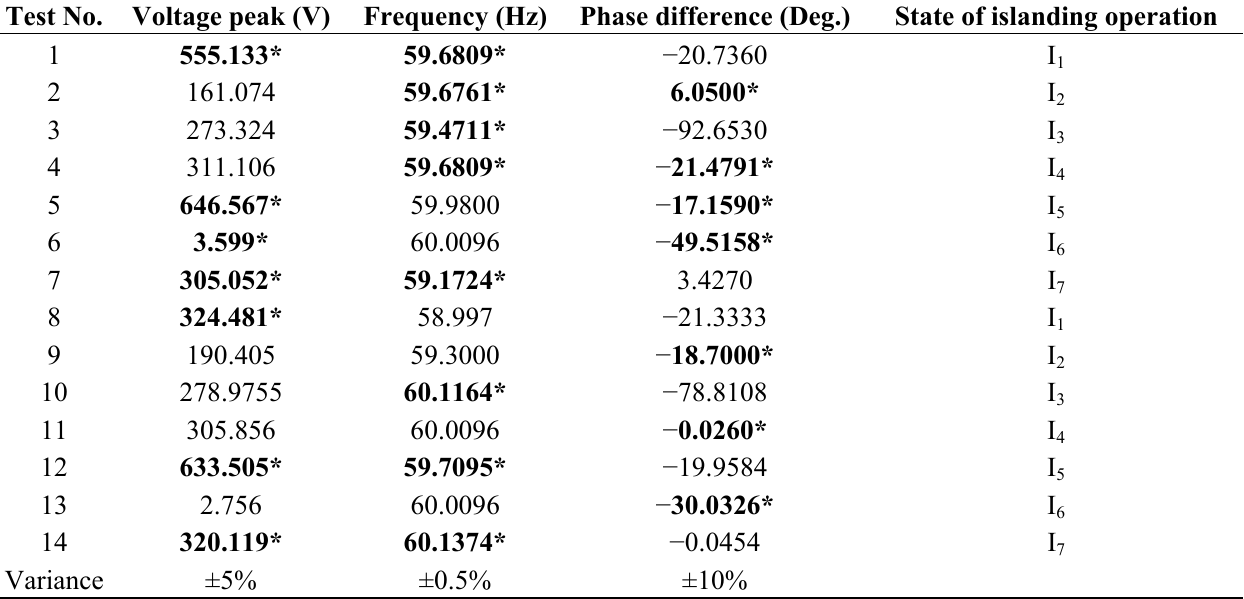
Table 6. Test data for detecting islanding with added